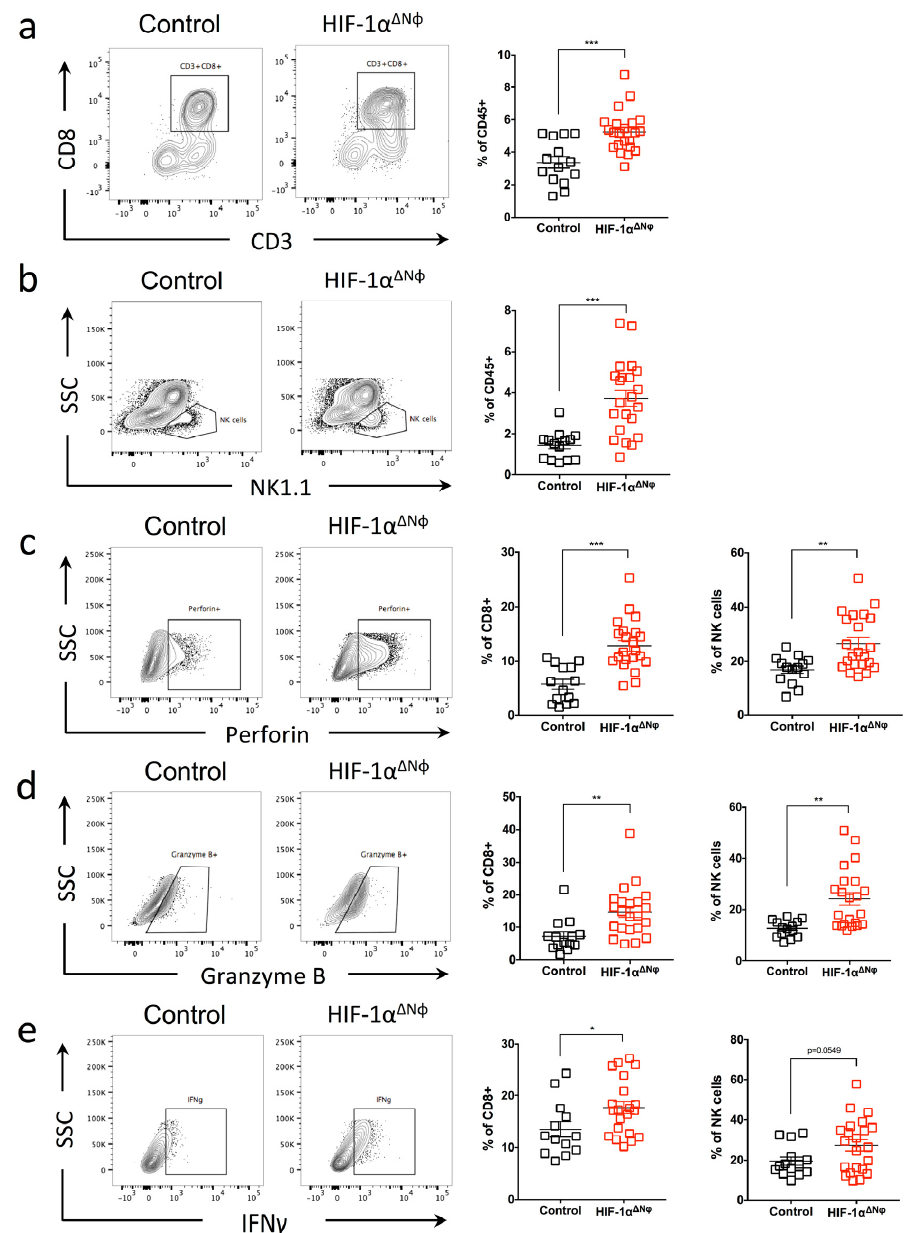
Figure 7. Anti-tumoral effector responses are supported by CD8+ T cells and NK cells activation and cytotoxicity. ( a – e ) Flow cytometry was performed in HIF-1 α ∆ N ϕ orthotopic transplanted (OT) and littermate HIF-1 α fl/fl control mice to assess cytotoxic T lymphocytes (CTL) and natural killer (NK) cell populations. CTL are gated based on their expression of CD45 + CD90.2 + CD3 + CD8+ and NK cells are gated based on their expression of CD45 + CD90.2-CD19-NK1.1+. Shown are scatter plots of ( a ) the % CD3 + CD8+ T cells, and ( b ) % NK cells of the total CD45+ population in the pancreata of HIF-1 α ∆ N ϕ OT (red clear) and control OT (black clear) mice (HIF-1 α ∆ N ϕ n = 22, control n = 14 mice per group, pooled from three independent experiments). CTL and NK cells were stimulated with 10 ng/mL PMA and 1 µ M ionomycin for 4 h. Scatter plots indicate the percentage ( c ) Perforin+, ( d ) Granzyme B+, and ( e ) IFN- γ + cells of total CTL and NK cells in the pancreata of HIF-1 α ∆ N ϕ OT (red clear) and control OT (black clear) mice (HIF-1 α ∆ N ϕ n = 22, control n = 14 mice per group, pooled from three independent experiments). Data represent the means ± SEM, * p < 0.05; ** p < 0.01; *** p < 0.001 by unpaired Student’s t -test with a 95% confidence